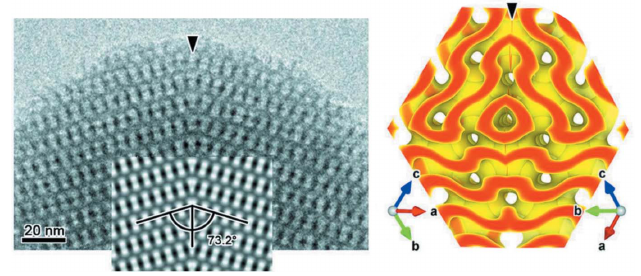
Figure 1 HRTEM image of bincontinous cubic ( Ia (cid:2) 33 d ) mesoporous silica crystal showing a {211} twin boundary (left) and 3D reconstructed models of the silica network of the G-twin boundary. Adapted from (Han et al. ,